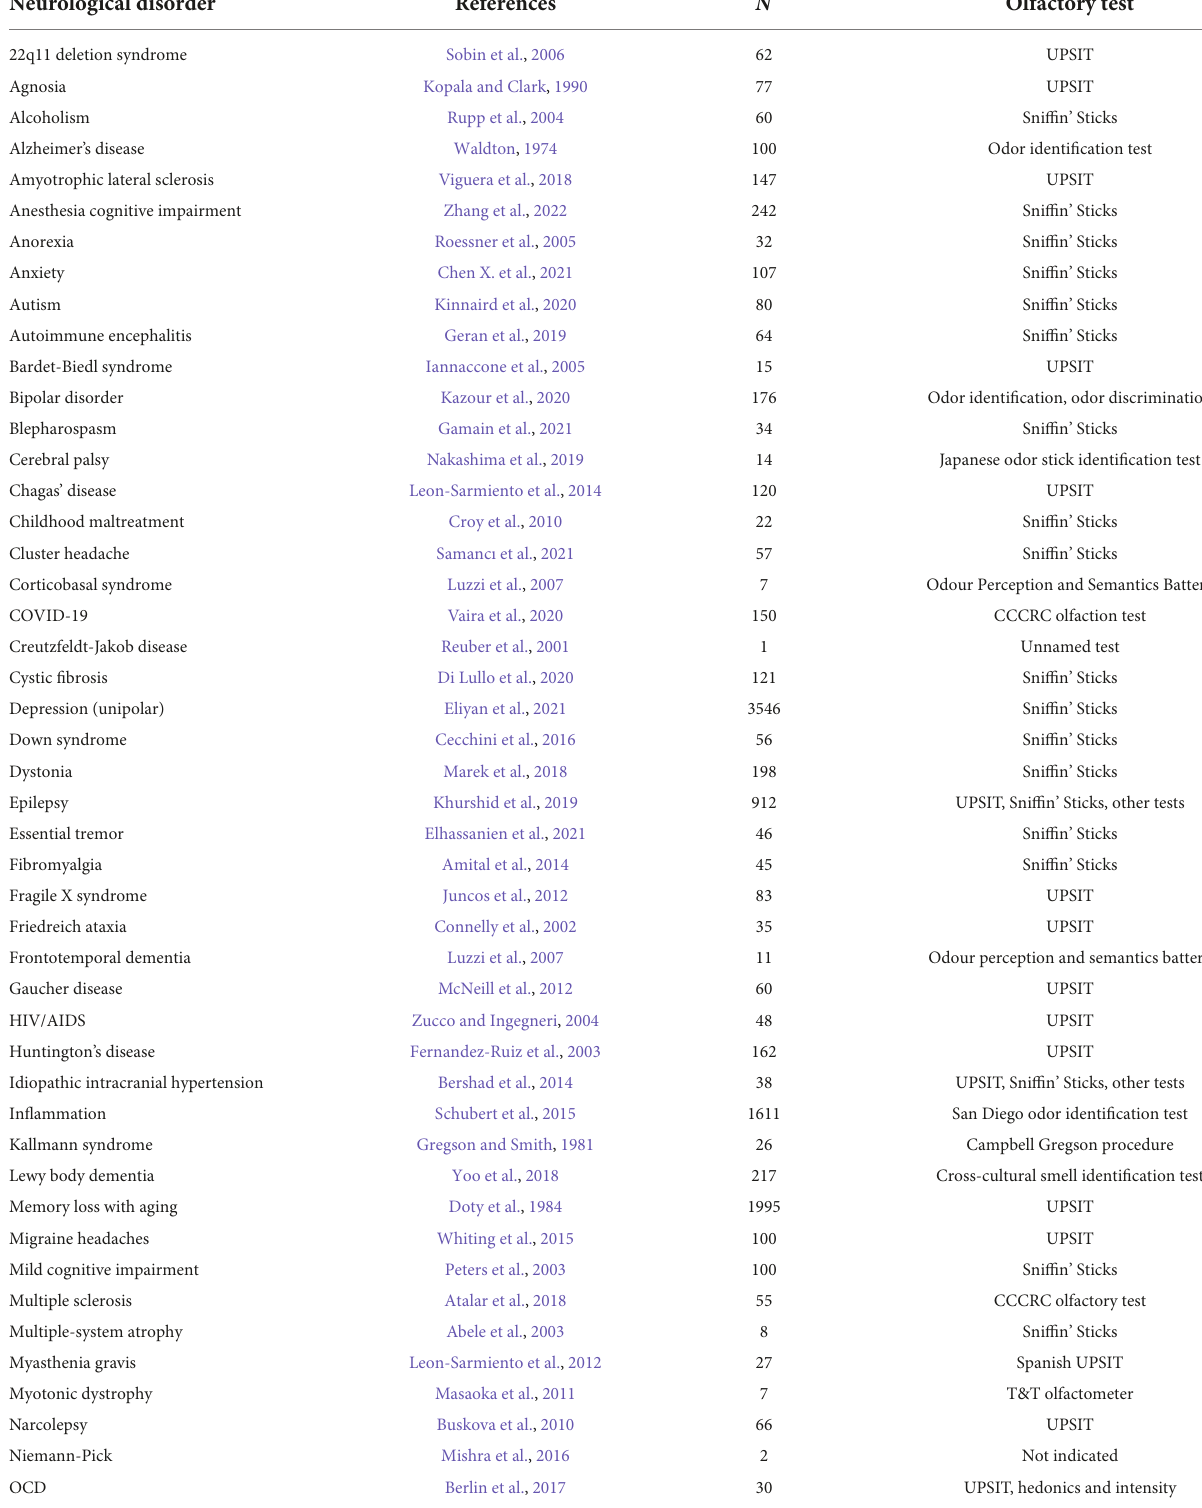
TABLE 1 Neurological disorders associated with olfactory